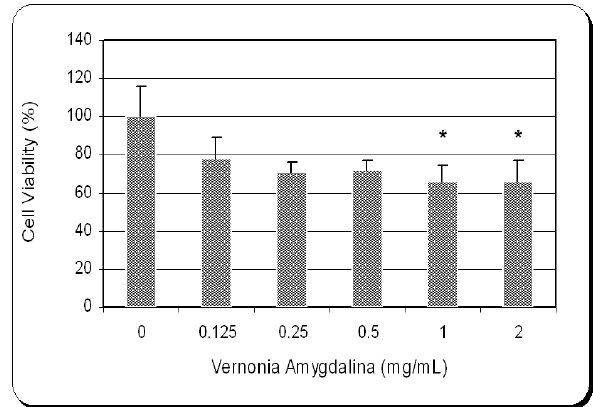
Figure 1: Cytotoxic Efficacy of Vernonia amygdalina (VA) leaf extracts to human breast adenocarcinoma (MCF- 7) cells. MCF-7 cells were cultured with different doses of VA for 48 hours as indicated in the Materials and Methods. Cell viability was determined based on the MTT assay. Each point represents a mean ± SD of 3 experiments with 6 replicates per dose. *Significantly different ( p < 0.05) from the control, according to the Dunnett’s test.